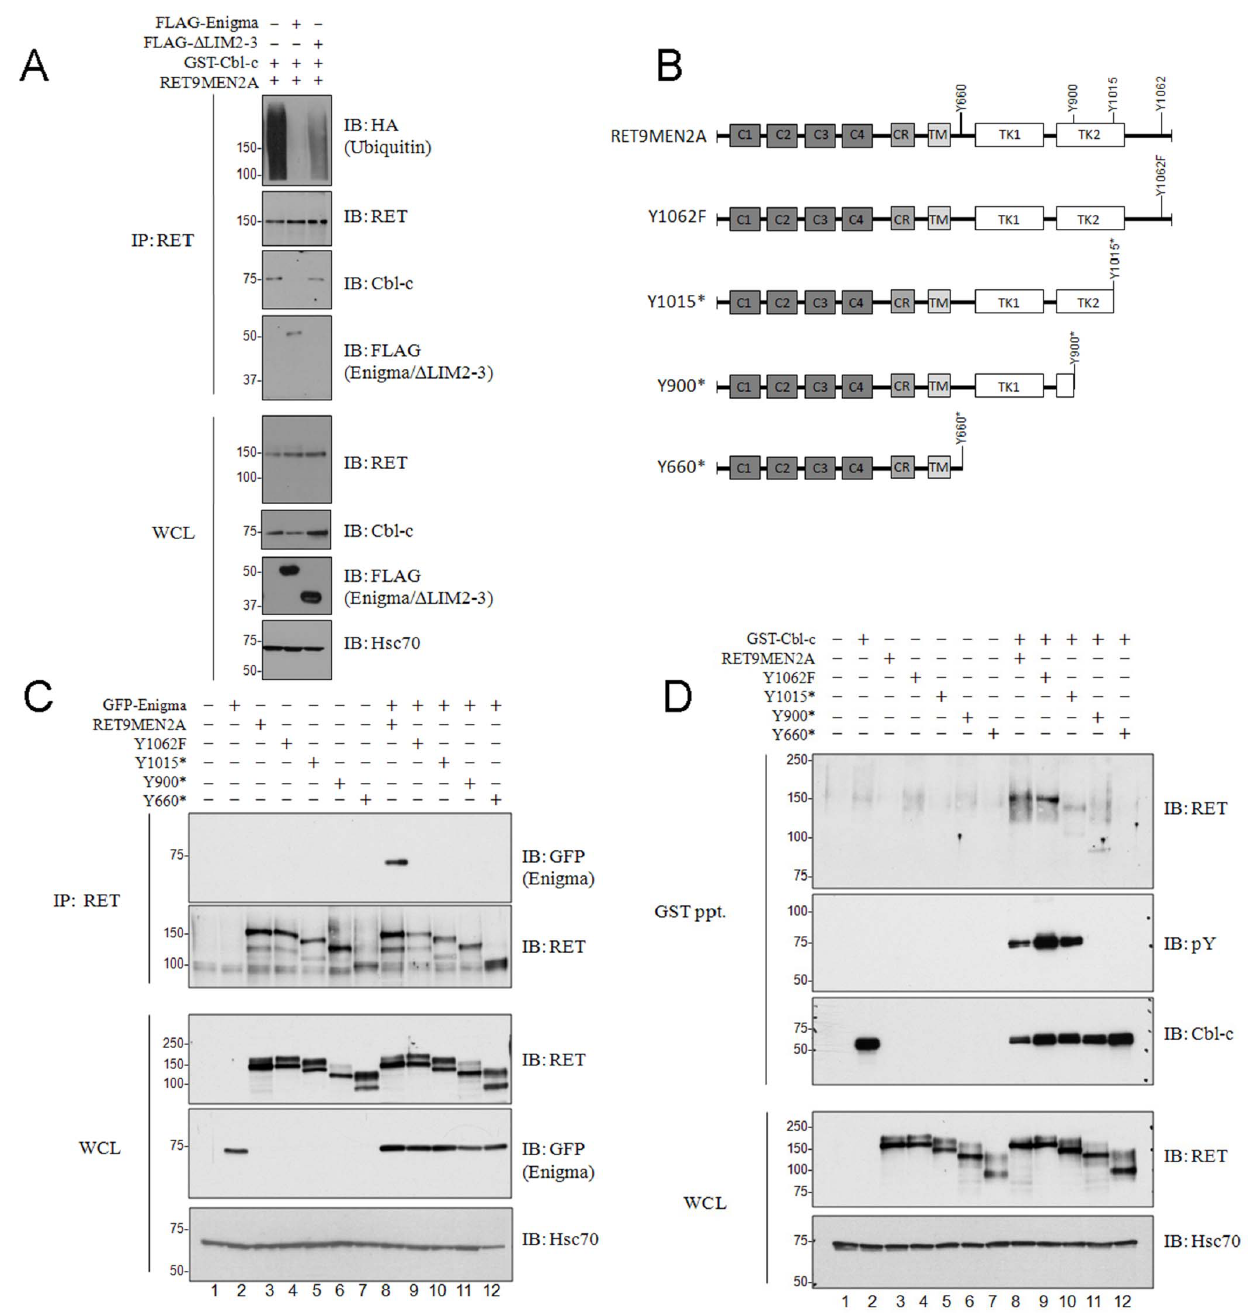
Figure 4. Enigma blocks Cbl-c-mediated RET9MEN2A ubiquitination. ( A ) HEK293T cells were transfected with RET9MEN2A along with GST- Cbl-c, FLAG-Enigma or FLAG-Enigma D LIM2-3 alone and in combination as indicated above the blots. All transfections included an equal amount of HA-ubiquitin. At 40h post-transfection, all cells were treated with 20nM MG-132 for 5h prior to cell collection. A total of 20 m g of each of the whole cell lysates were immunoblotted as indicated on the right. RET immunoprecipitations were performed on 300 m g of whole cell lysate and immunoblotted for RET and HA-ubiquitin. Co-immunoprecipitation of Cbl-c and Enigma were evaluated as indicated on the right. Molecular weight standards are indicated to the left of each panel and Hsc70 serves as a loading control. ( B ) RET truncation constructs used for mapping Cbl-c and Enigma interaction sites. Structural domains include the extracellular cadherin-like repeats (C1-4), a cysteine rich region (CR), a hydrophobic transmembrane region (TM), a split cytoplasmic tyrosine kinase domain (TK1 and TK2), and intracellular tyrosines subsequently mutated to an F or stop (*) to create each construct used in this study. ( C ) HEK293T cells were transfected with GFP-tagged Enigma both alone and in combination with RET9MEN2A or one of a series of RET9MEN2A mutant constructs as indicated above each blot. A total of 20 m g of each of the whole cell lysates were immunoblotted as indicated on the right. RET immunoprecipitations were performed on 300 m g of each of the whole cell lysates and immunoblotted for GFP-Enigma. Molecular weight standards are indicated on the left of each panel and Hsc70 serves as loading control. ( D ) HEK293T cells were transfected with each of the RET9MEN2A constructs both alone and in combination with GST-Cbl-c as indicated above each blot. All transfections were balanced with empty vector controls, and cells were collected 48 h post-transfection. A total of 20 m g of each of the whole cell lysates were immunoblotted as indicated on the right. GST pull-downs were performed on 300 m g of each of the whole cell lysates and immunoblotted for Cbl-c,